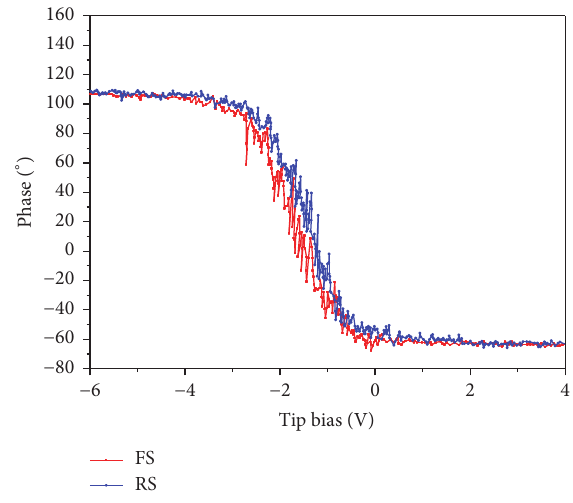
Figure 7: Phase-voltage curve of the typical CH 3 NH 3 PbI 3 per- ovskite film, collected by PFM at the fixed conductive tip with DC bias from − 6V to +4V and AC bias of